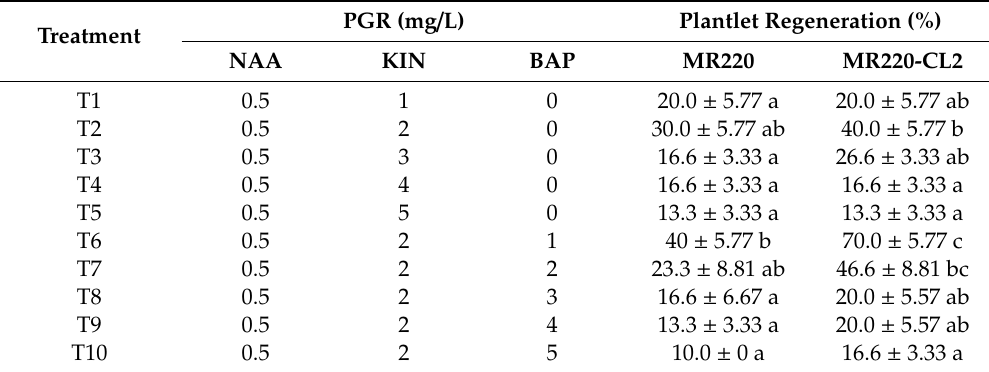
Table 2. The e ff ect of Kinetin and benzyl-amino-purine (BAP) on the percentage of regenerate plantlet from MR220 and MR220-CL2